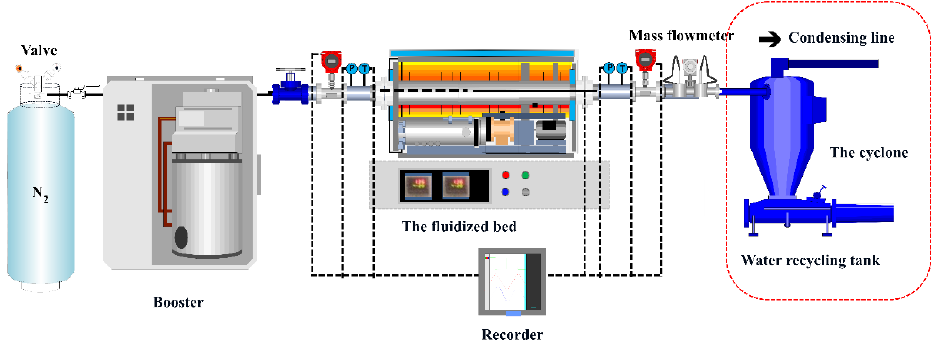
Figure 1. Low-rank coal pyrolysis and product separation